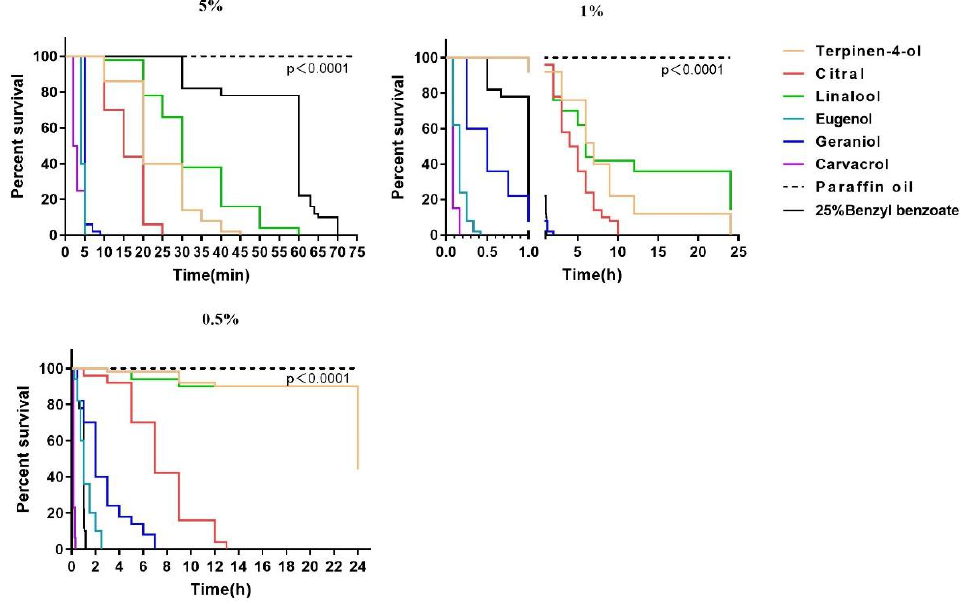
Figure 1. Survival curves of Sarcoptes scabiei mites exposed to 5%, 1%, and 0.5% solutions of six terpenes.